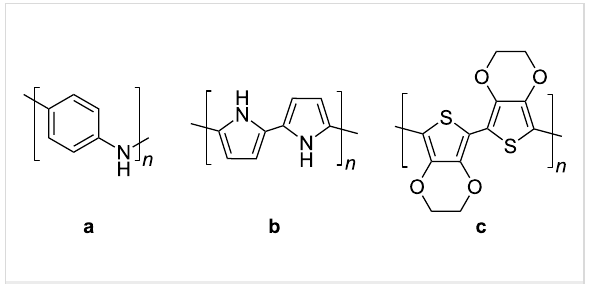
Figure 6: Chemical structure of a: polyaniline (leucoemeraldine), b: polypyrrole, c: poly(ethylene dioxythiophene).